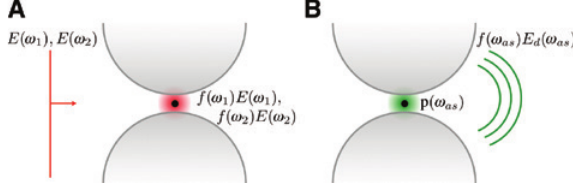
Figure 9: The CARS excitation and radiation of a point dipole in the presence of a plasmonic antenna. (A) The incident fields E ( ω ) and E ( ω ) couple to the antenna, 1 2 respectively. The point dipole is driven by the local fields, setting up a nonlinear polarization. (B) The nonlinear polarization at frequency enhanced by a factor f ( ω as